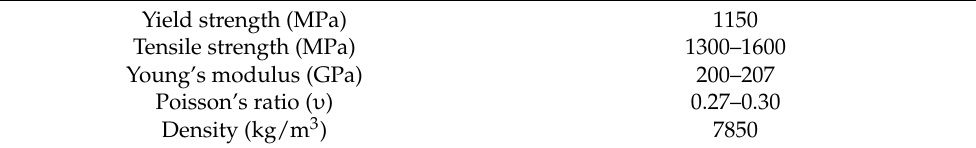
Table 3. Material properties of the tension clamp (38Si7).